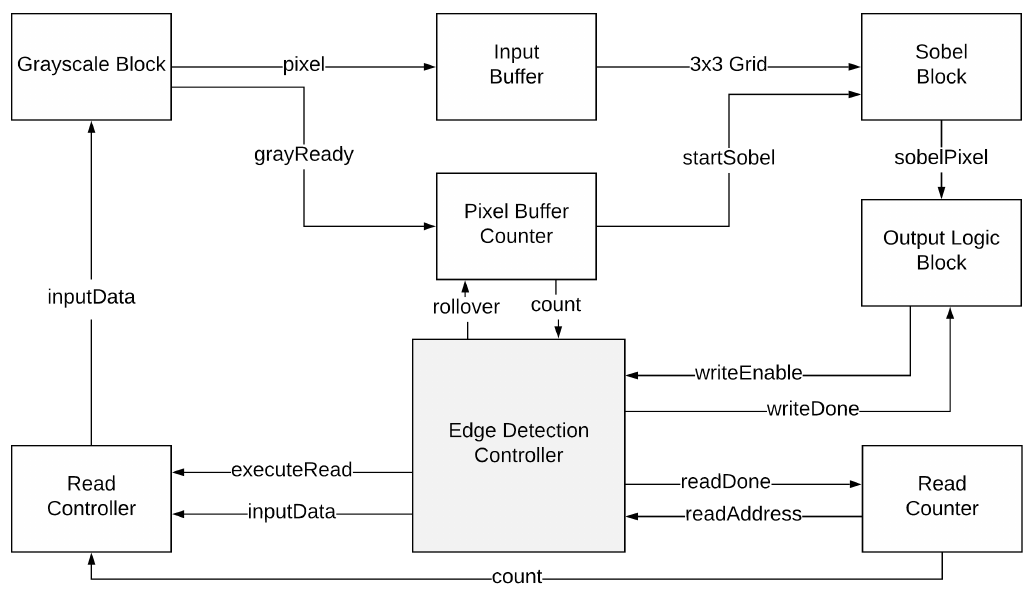
Figure 3. Functional block diagram.